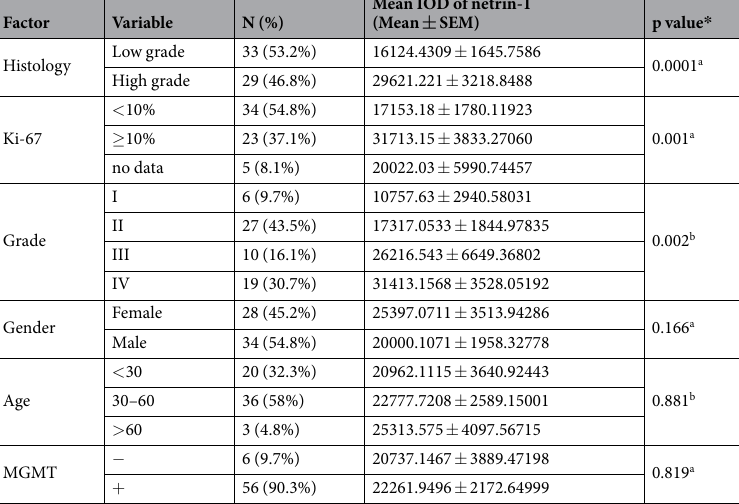
Table 1. The 62 glioma patients’ classified statistic according to clinical pathological features. a Student’s t-test; b One-way